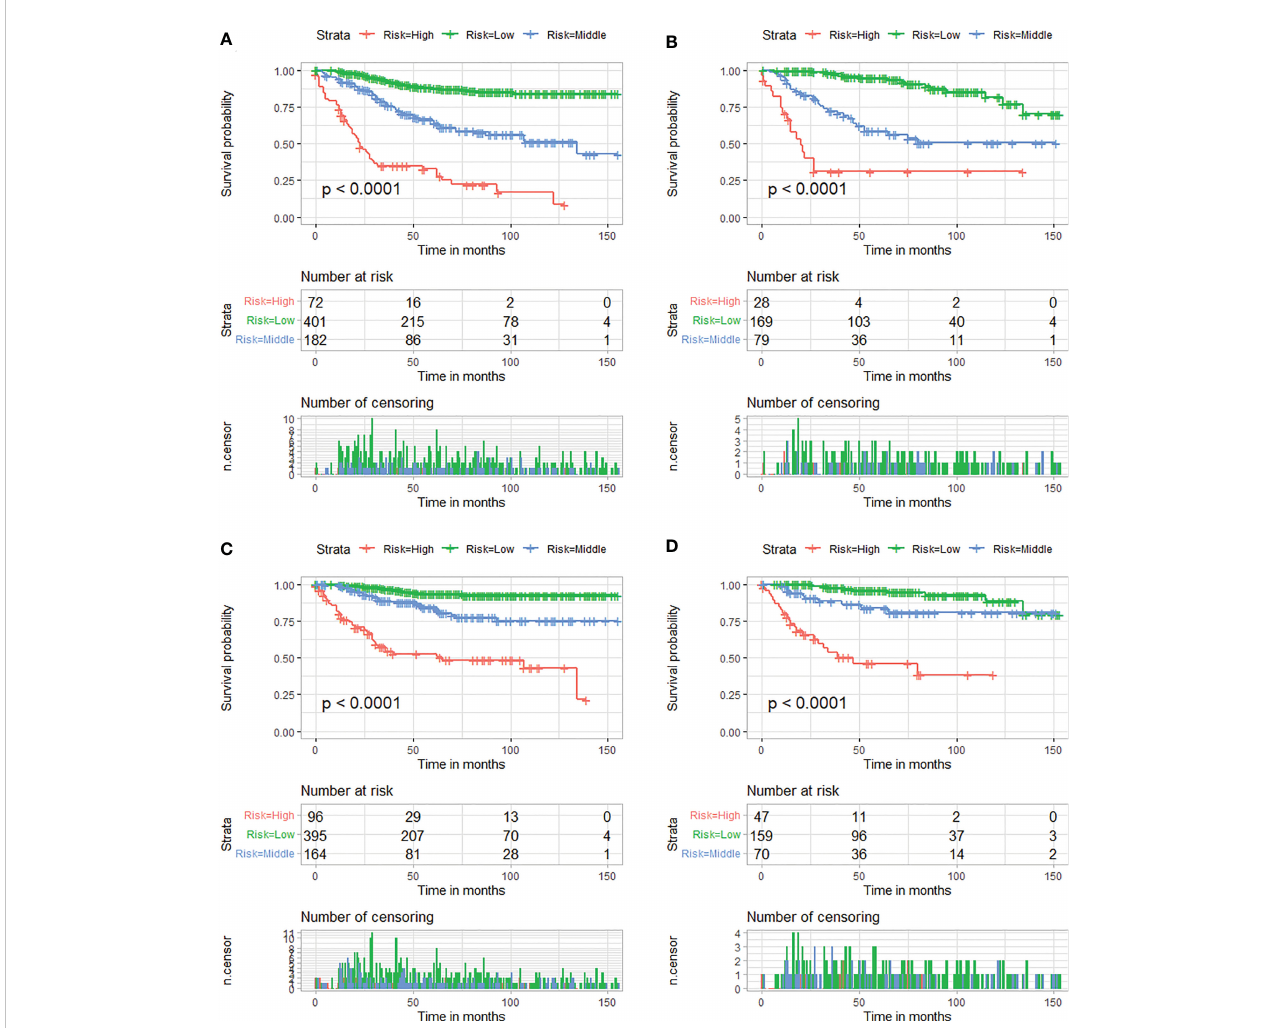
FIGURE 8 Kaplan – Meier survival curves of three mortality risk subgroups for OS in the training cohort (A) and veri fi cation cohort (B) . Kaplan – Meier survival curves of three mortality risk subgroups for CSS in the training cohort (C) and veri fi cation cohort (D) .